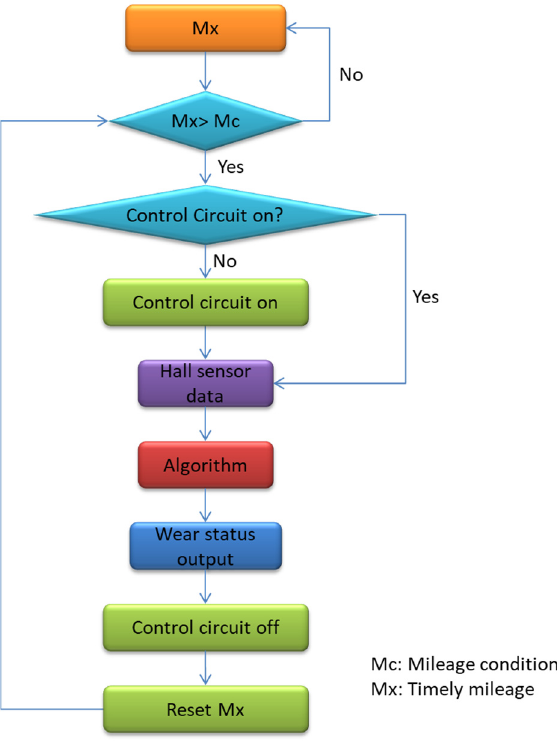
Figure 9. The Hall sensor power control